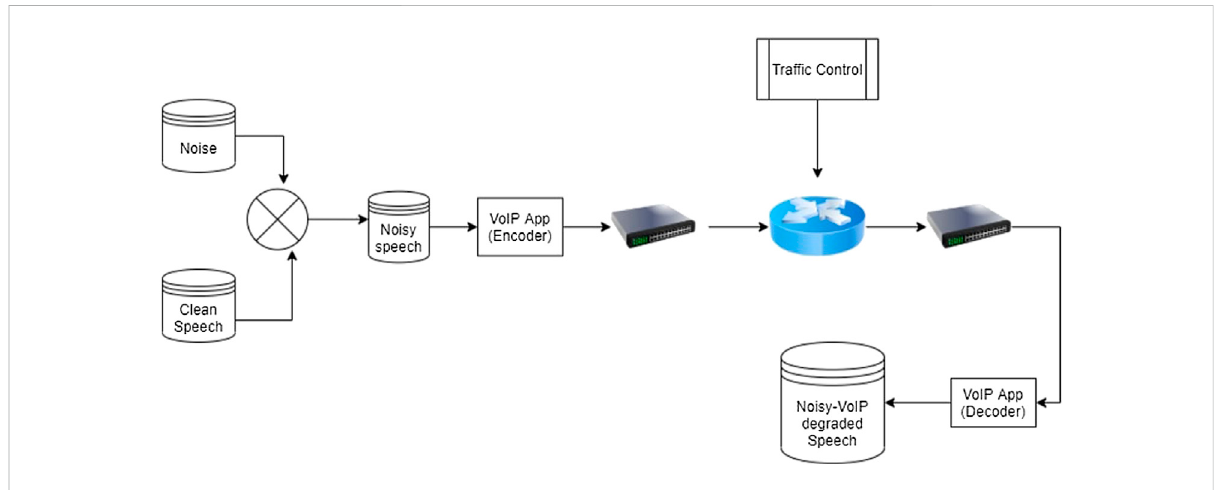
FIGURE 1 Noise-network speech dataset generation